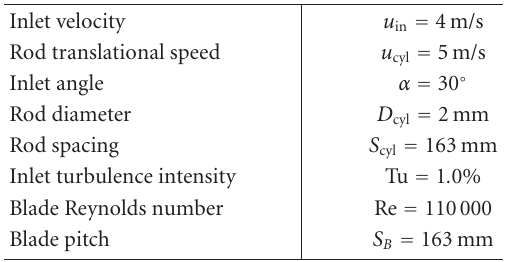
Figure 3: Strouhal number in dependence on the temporal resolu- tion.